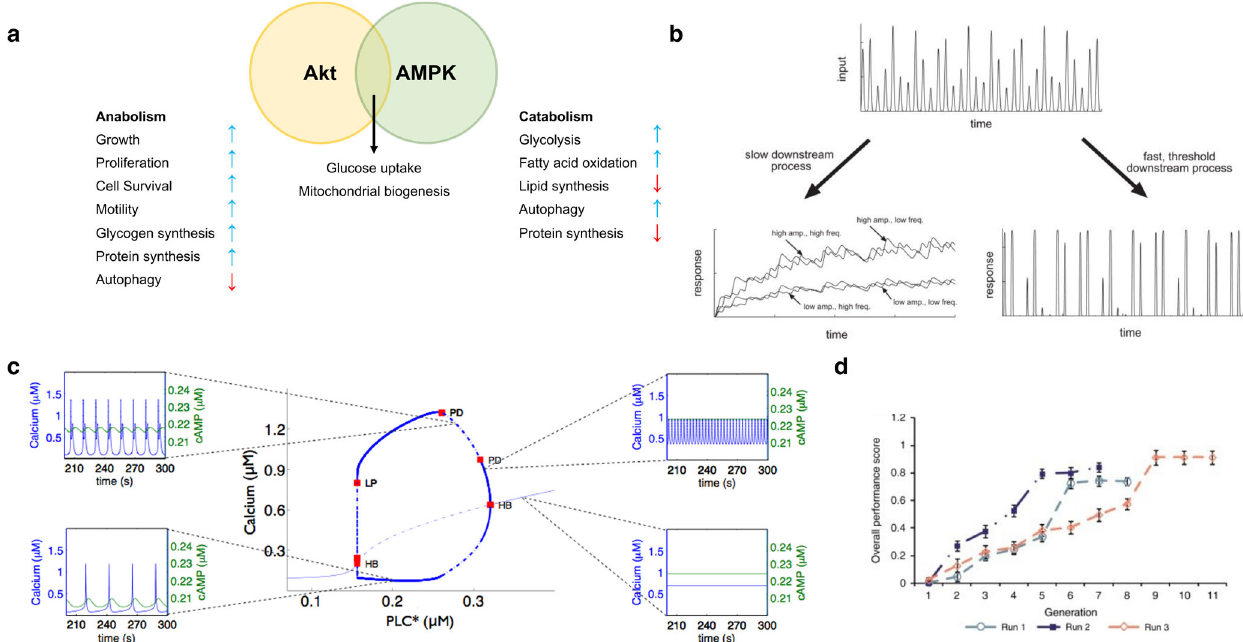
Fig. 4 Interdependency of consolidating signal transduction pathways, and oscillatory signaling processes and second messengers coordinating tissue function, in introducing complexity when setting optimization metrics, prescribed signaling targets, or scoring paradigms. a Opposing and aligned roles of Akt and AMPK in cell processes. b Oscillatory inputs (e.g., [Ca 2 + ] or [cAMP]; top) can be decoded on an amplitude-dependent (left) or frequency-dependent (right) basis based on receiver process kinetics being slow or fast, respectively, lending further mutability to the physiological manifestation of a set of interdependent and multi-step signaling pathways 376 . Reproduced with the express permission of the publisher and authors. c Simulated interactions between calcium and cAMP levels in a model of mutual enzymatic activation, based on active phospholipase C β (PLC β ) concentration and a set adenylate cyclase concentration of 0.17 µM 248 ; demonstrating interdependency of second messenger kinetics on their ultimate manifestation as an output response. Reproduced under a CC-BY license with express permission of the authors. d Sample visualization of an iterative High Dimensional, Differential Evolutionary (HD- DE) algorithm with successive generations outperforming each other on a normalized objective metric, with biological variability represented by temporary differences in performance between independent iterative runs that ultimately converge at highly-performing solution scores; this algorithm was used to optimize hematopoietic stem cell expansion medium ef fi cacy 388 . Reproduced under a CC-BY license with express permission of the